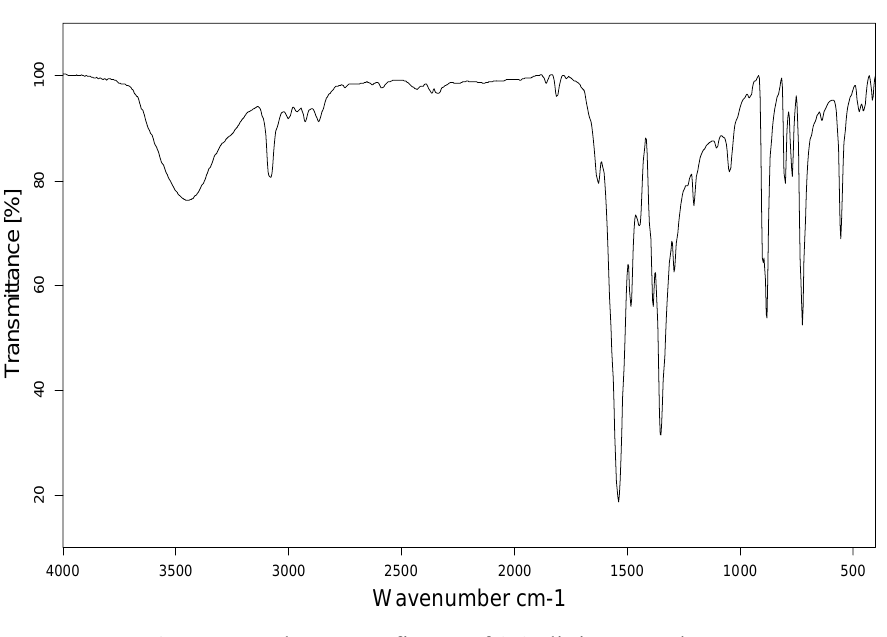
Figure 11. The FT-IR figure of 2,6-dinitro-p-xylene